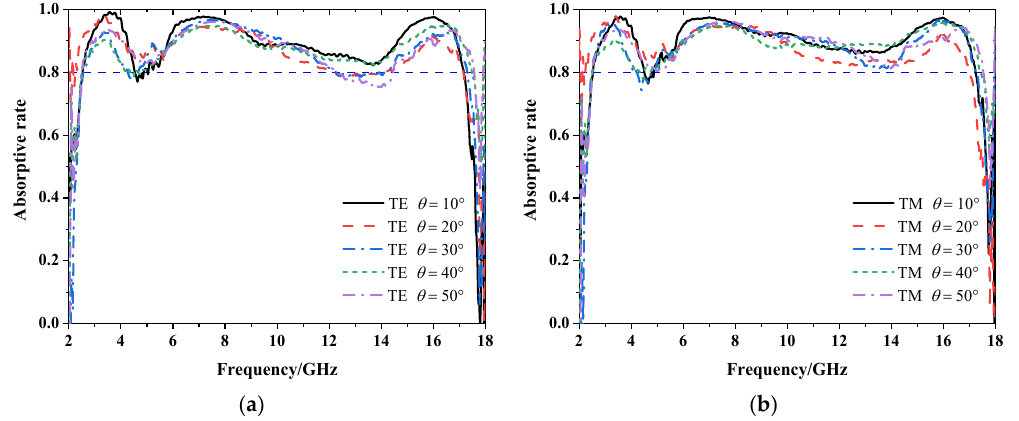
Figure 8. The measured absorptive rate under ( a ) TE and ( b ) TM polarizations with oblique incident angle of 10°–50°. Table 2. Comparison of this work and previous